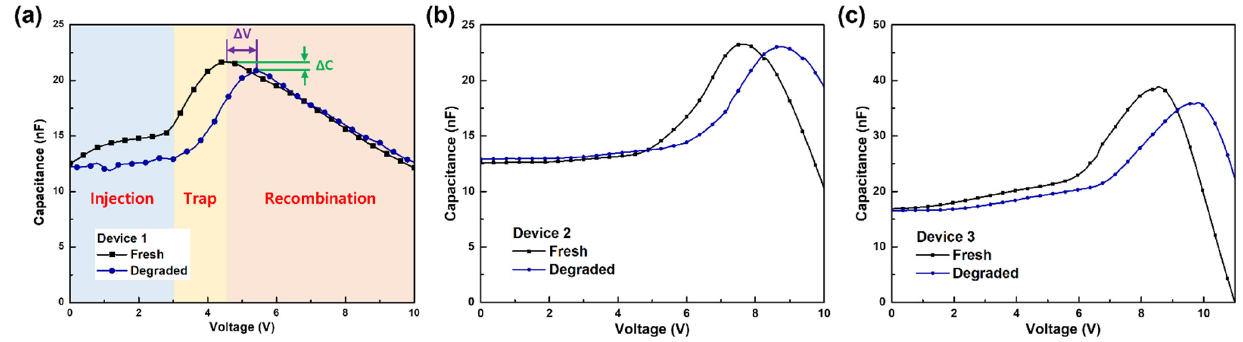
Figure 3. C-V characteristics of blue TADF OLEDs before and after degradation: ( a ) device 1, ( b ) device 2, and ( c ) device 3. Table 3. Peak voltage and peak capacitance shift values after degradation of devices 1, 2, and 3.